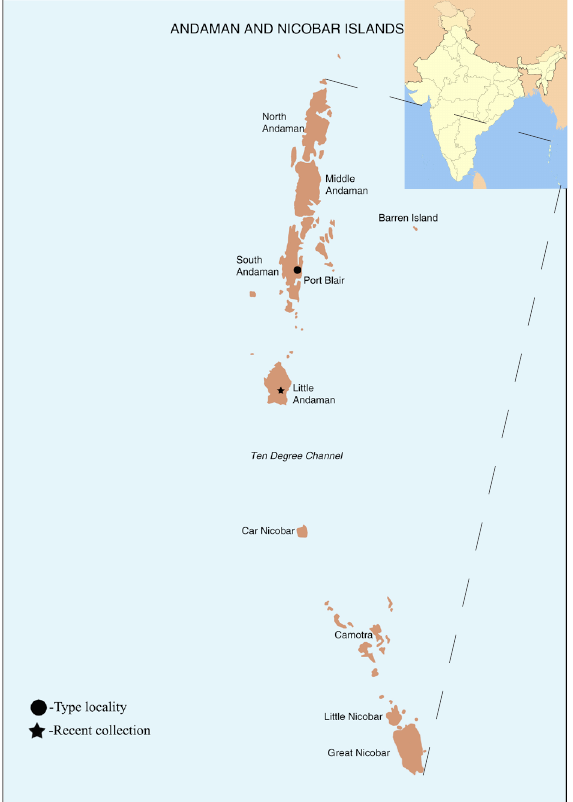
Image 1. Andaman and Nicobar Islands giving the distribution of Ginalloa andamanica